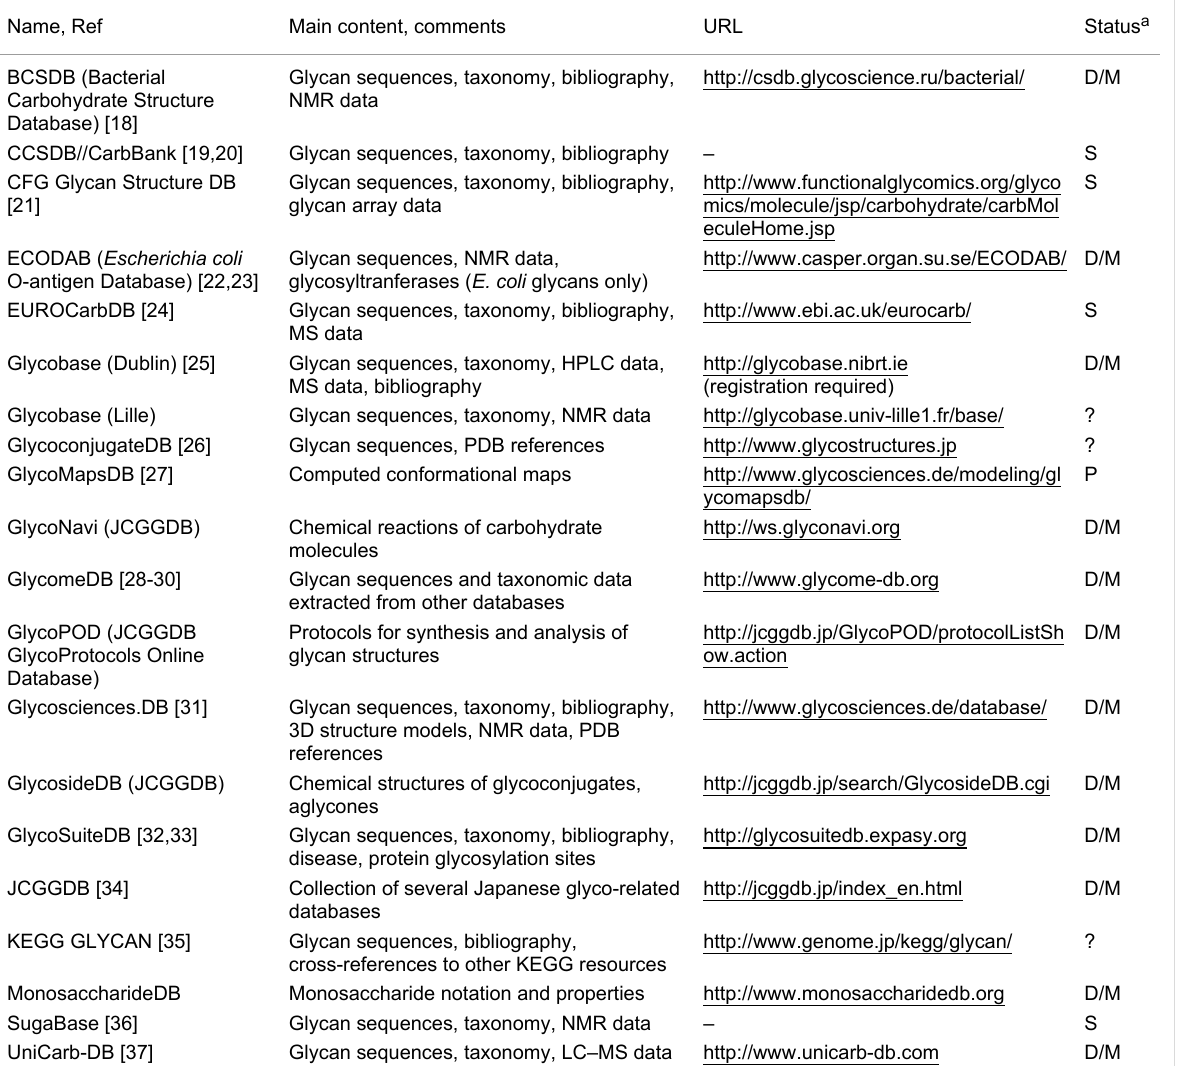
Table 1: Carbohydrate structure